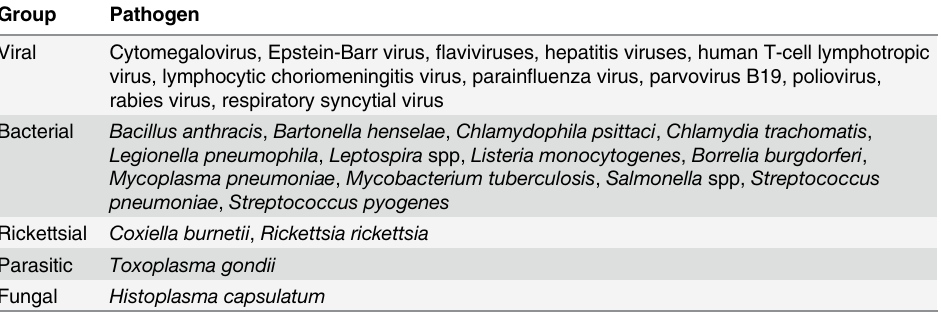
Table 2. Additional pathogens investigated in patients in whom panel 1 testing was negative as deter- mined by the expert review panel for the HPA Study of the Aetiology of Encephalitis in